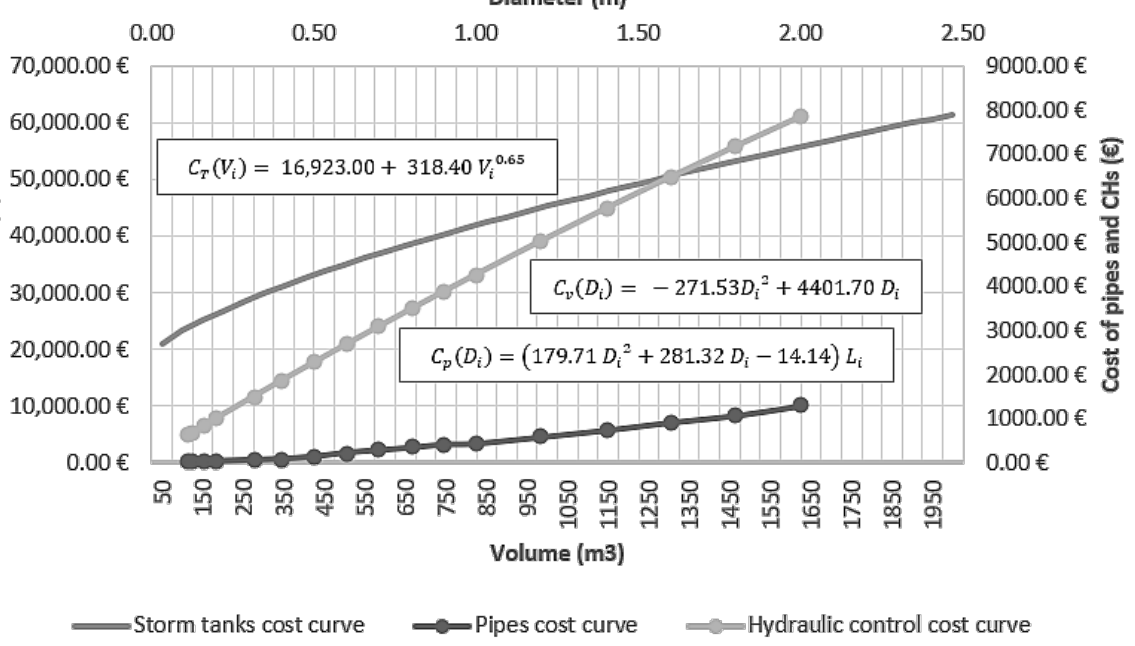
Figure 9. Cost curves of pipelines, STs and HCs for the case study.